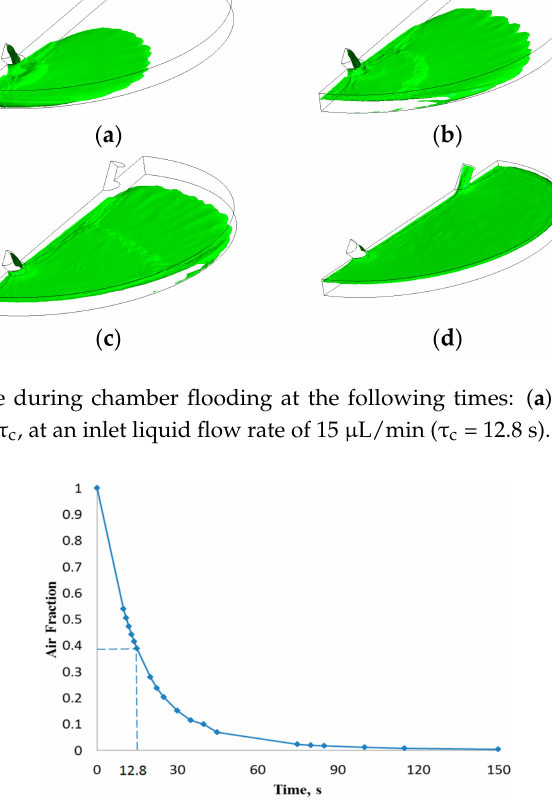
Figure 4. Overall air volume fraction in the chamber vs. filling time at a liquid flow rate of 15 µ